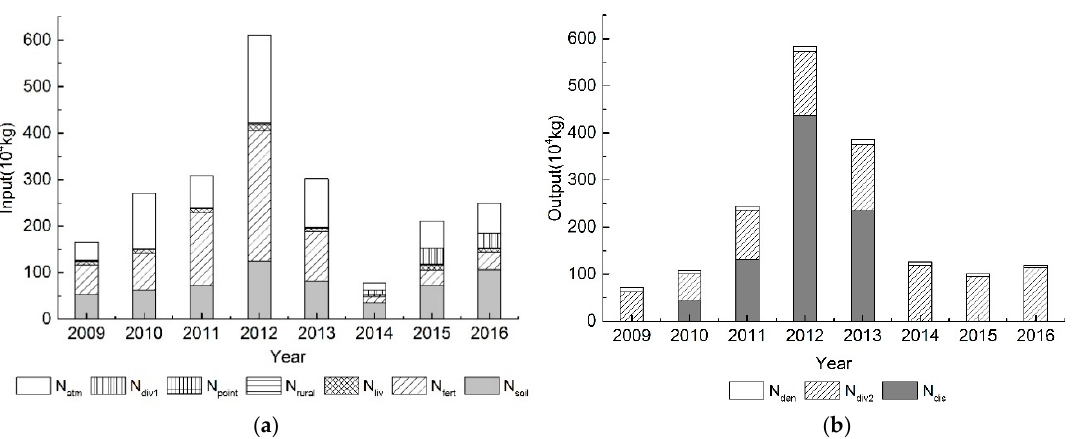
Figure 7. The composition of annual TN input ( a ) and output ( b ) fluxes of the Biliuhe reservoir from 2009–2016.